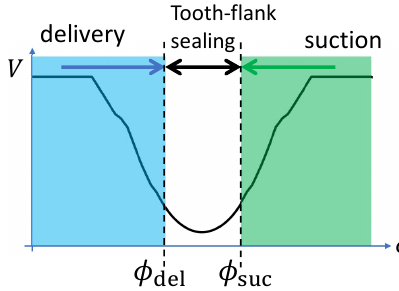
Figure 12. Tooth-flank contact sealing for EGPs without relief